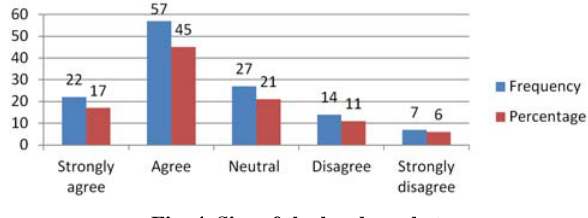
Fig. 4. Size of the local market